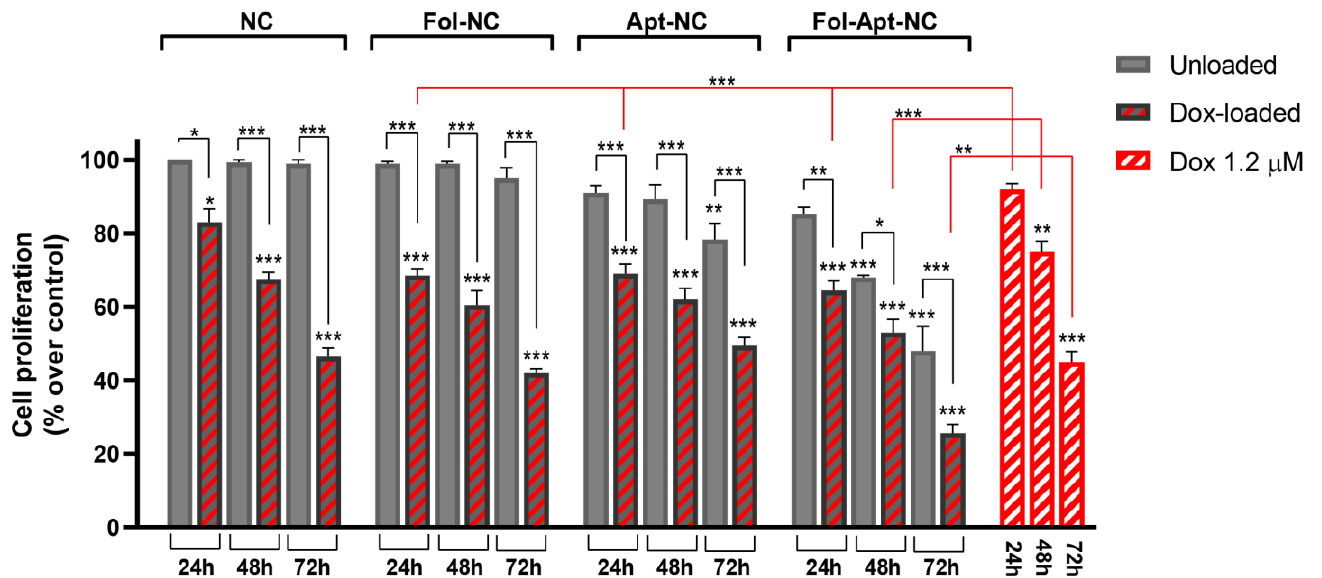
Figure 3. Cytotoxic effect of Dox-loaded or not-loaded NC, Fol-NC, Apt-N,C and Fol-Apt-NC and of free Dox in MDA-MC-231 cells. Cell proliferation of cells treated with NC, Fol-NC, Apt-NC, and Fol-Apt-NC not loaded (light gray) or loaded with Dox (gray and red striped) and free Doxorubicin (red and white striped) at different times, as indicated, was evaluated with MTS assay. The data represent mean ± S.E.M. of three separate experiments. The values are the mean of six replicates, normalized on cell proliferation of untreated cells. Statistical analysis was performed to compare at each time point (i) all groups vs. untreated cells, (ii) Dox-loaded-NC groups vs. unloaded-NC treated cells, and (iii) free Dox treated vs. Dox-loaded-NC treated cells. Statistical significance: * p < 0.05, ** p < 0.01, and *** p < 0.01 (ANOVA